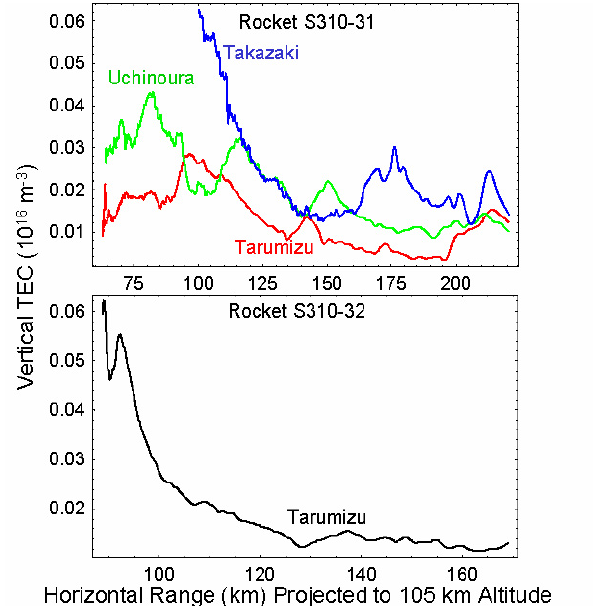
Fig. 5. Vertical TEC at 105km altitude derived from slant TEC obtained during the flight of the (a) first and (b) second SEEK-2